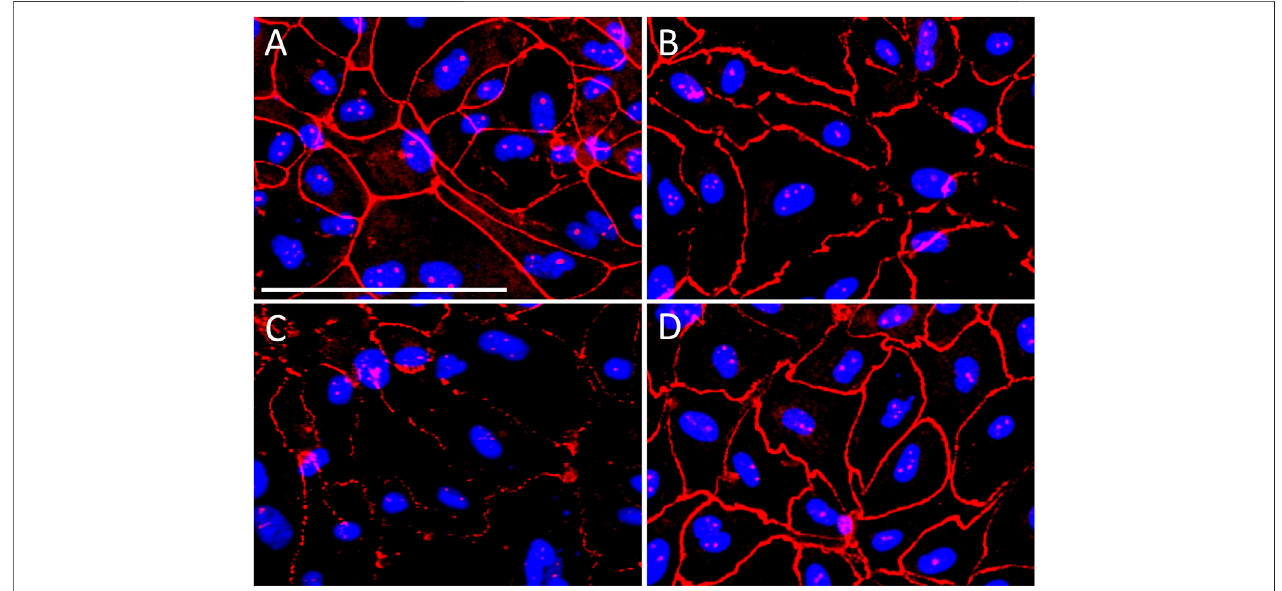
FIGURE 5 | Immunocytochemistry of tight junction protein zonula occludens-1 (ZO-1) (red) on primary cultured porcine bladder urothelial cells. ZO-1 immunoreactivity remained intact in (A) control cells and (B) cells treated with P2X7R antagonist A804598 (10 µM). Cells treated with acrolein (50 µM) for 4 h disrupted theintegrityofZO-1 immunoreactivity (C) .ZO-1 immunoreactivityremained intactinacrolein treatedcellsinthepresenceofA804598(10 µM) (D) .Theblue colorshows the nuclei stained with DAPI. Magni fi cation bar shows 100 µm.